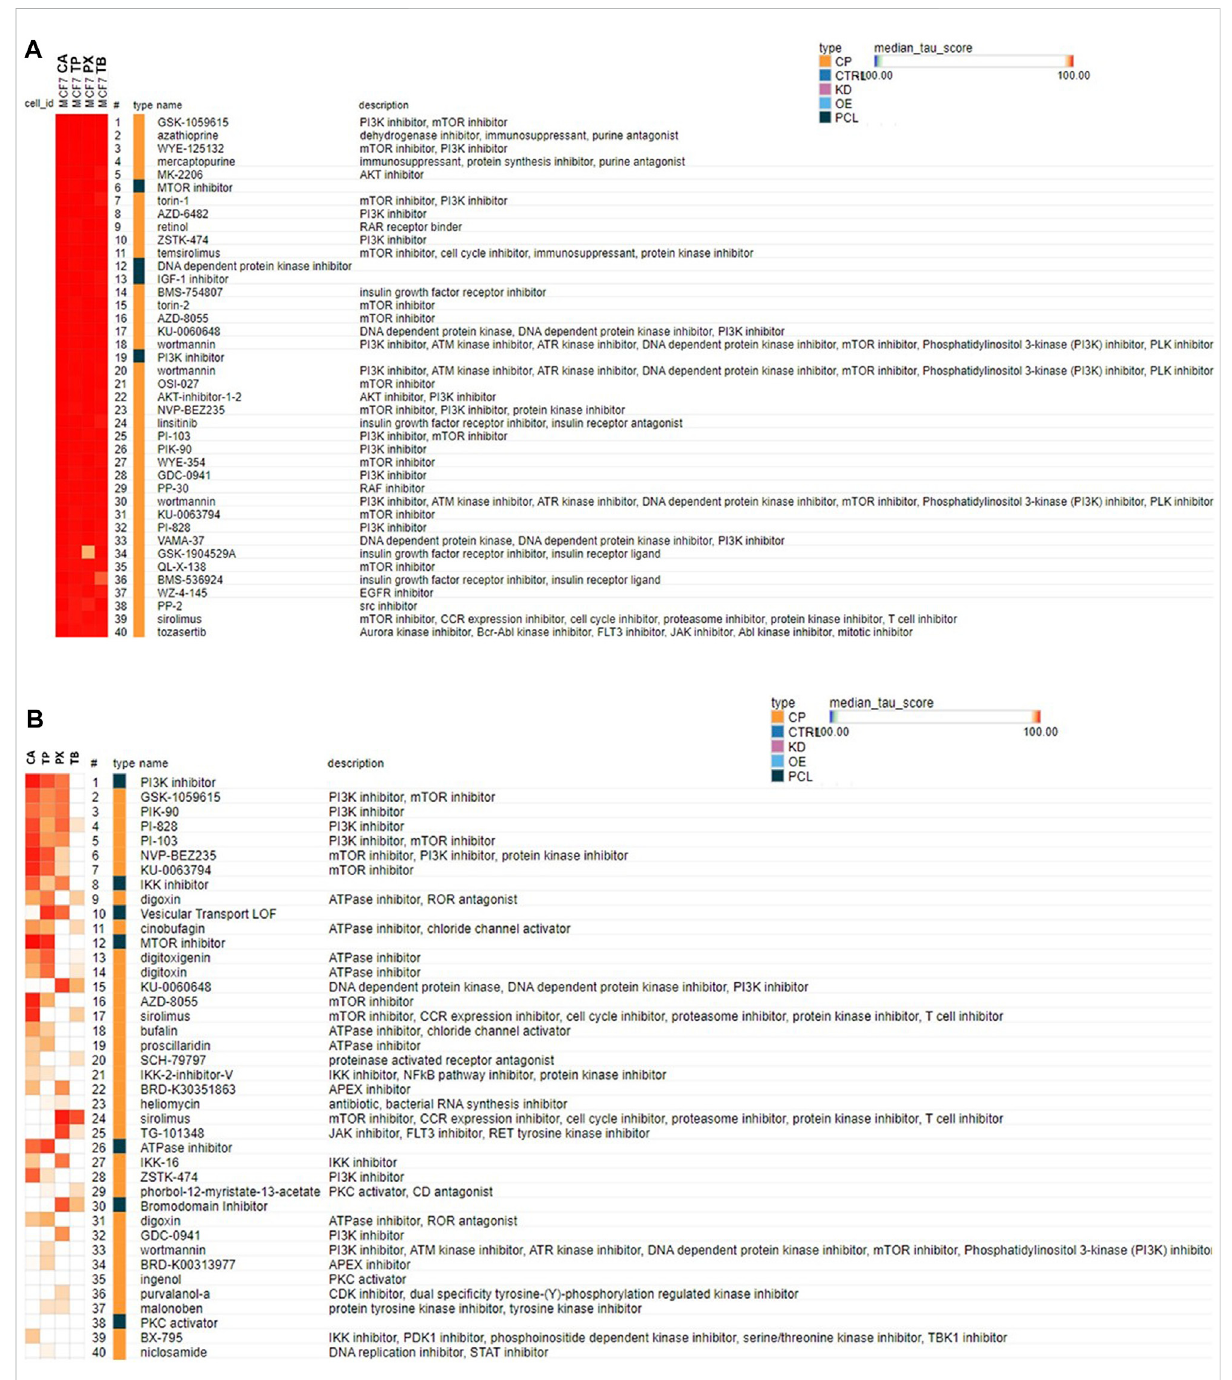
FIGURE 4 Connectivitymapanalysisusingthemostrobustresponsivegenesidenti fi edintheMCF-7cells (A) orcardiomyocytes (B) exposedtoCA,TP,PX or TB (at the highest concentrations tested, 1,000 μ M) in the Clue Touchstone database 1.0 set. The genes showing the most robust response after exposure to each chemical (top 100 up- or down-regulated genes with the smallest p values) were used for the cMAP analysis. Only the top 40 chemicals identi fi ed from the Broad Institute ’ s CLUE Touchstone data base, with similar transcript pro fi le to each chemical (positive connection) are shown. The same chemical could be listed multiple times (i. e. wortmannin), since the individual transcript pro fi le was obtained in different cell types, and or